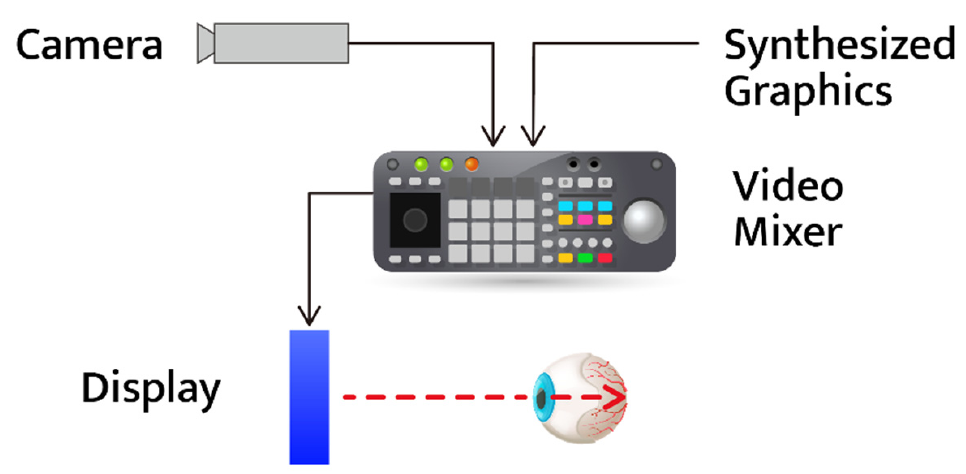
Figure 3. Video see-through display type.